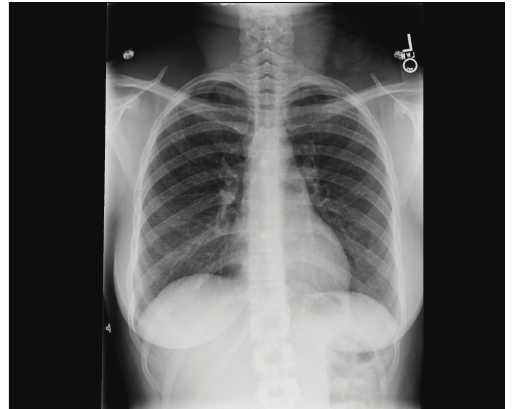
Figure 1: Chest X-ray.